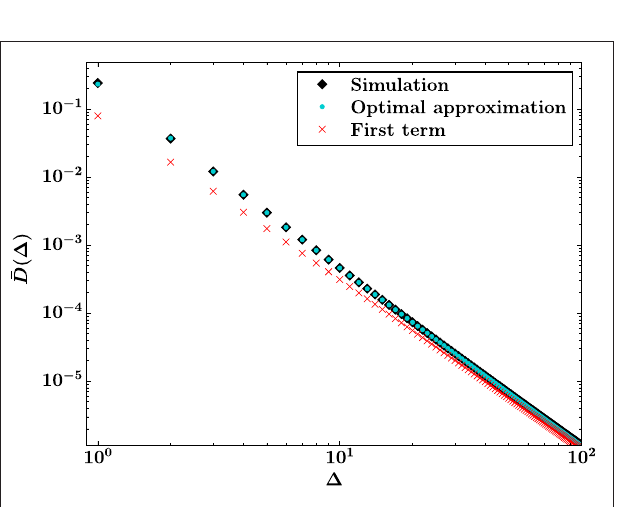
FIGURE 7 | Relative errors for the burst distribution with respect to simulation results that are averaged over 10 6 sample systems of size N optimal approximation from Equation (44) with 13 available terms (black) and for the first term of the asymptotic series (red), which is Equation (4). The threshold distribution is uniform on [0,1].